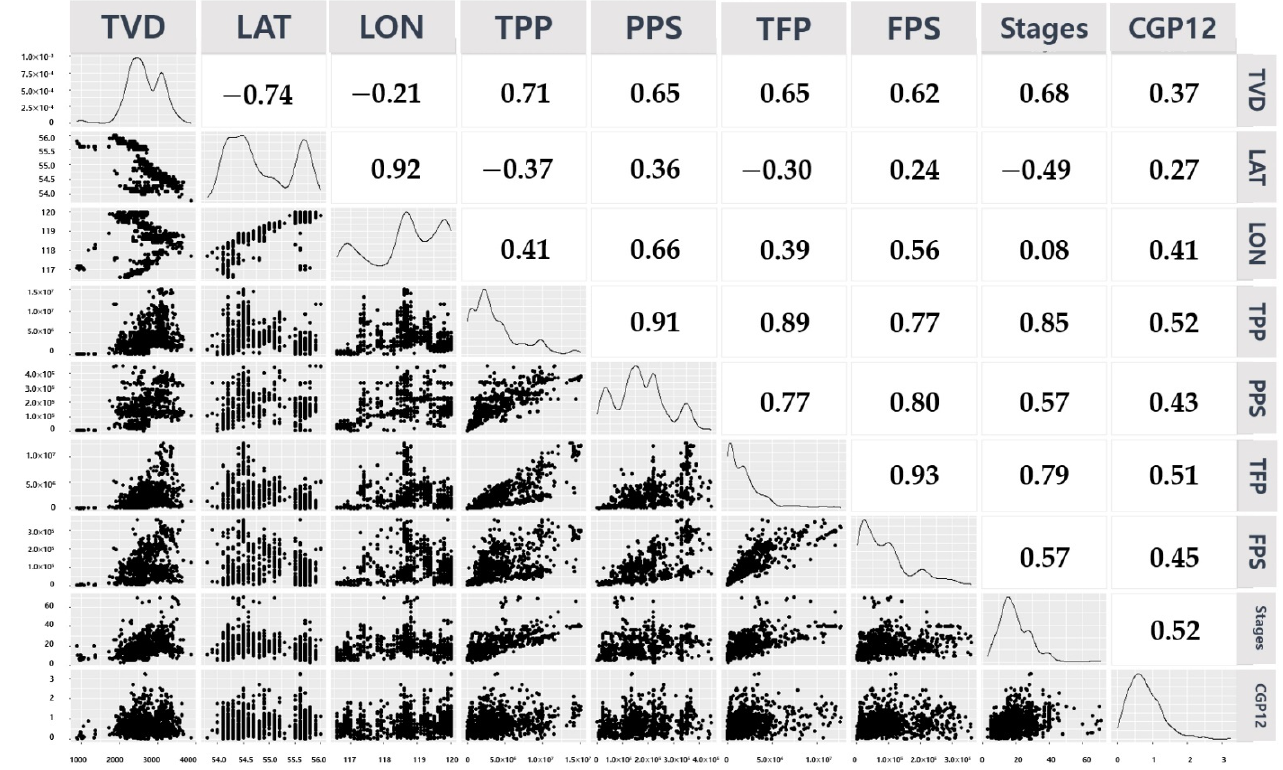
Figure 6. Scatterplots showing the relationship between the parameters, histograms of numerical variables and Pearson correlation coefficient values.